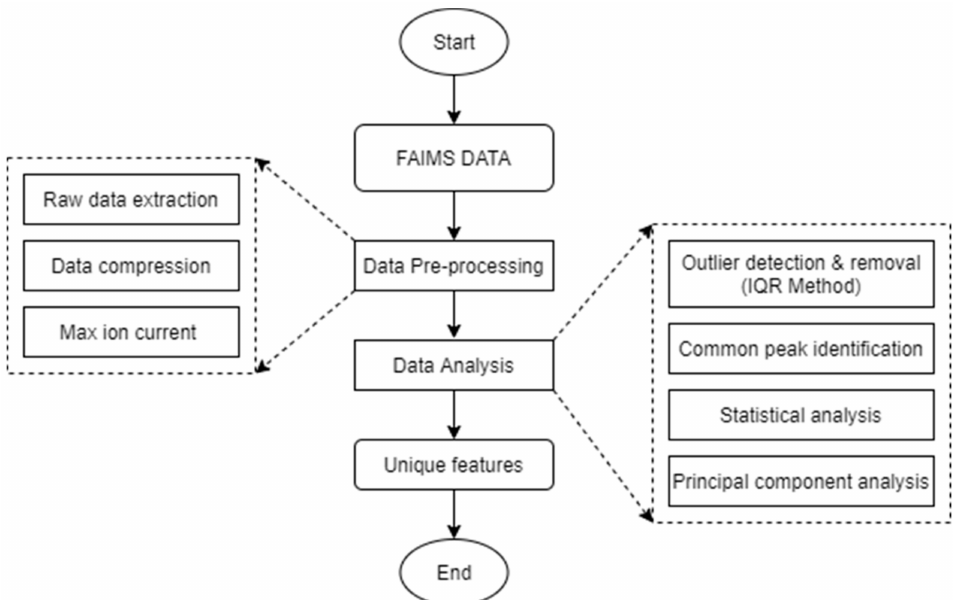
Figure 3. Field asymmetric ion mobility spectrometry data analysis flowchart. IQR refers to the interquartile